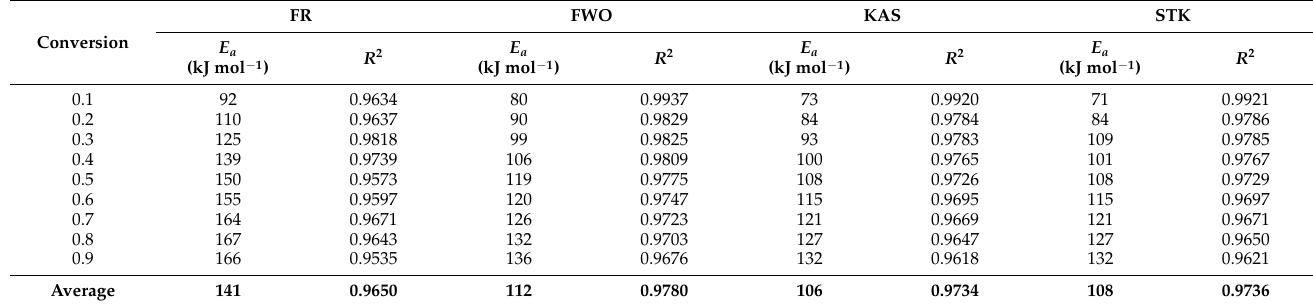
Figure 4. Activation energies for the FR, FWO, KAS, and STK of PP pyrolysis. Table 6. Activation energy of PP pyrolysis calculated by four model-free methods.